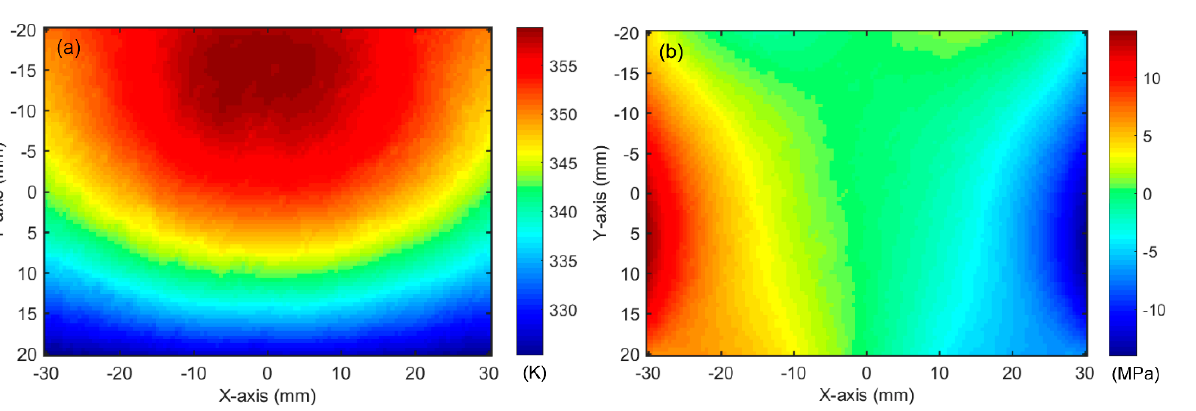
Figure 15. ( a ) Temperature distribution in central plane; ( b ) stress distribution in central plane.